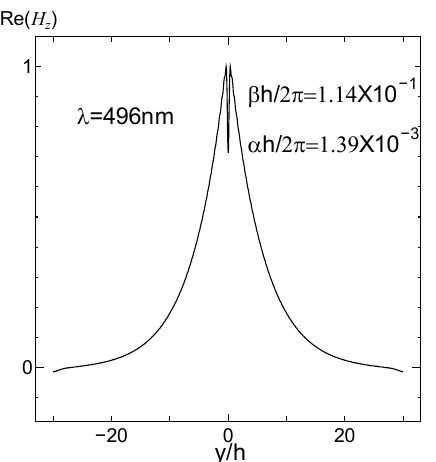
Figure 12. Distribution of the Hz field as a function of the y coordinate representing the wavelength of 496 nm (Palik experimental data).